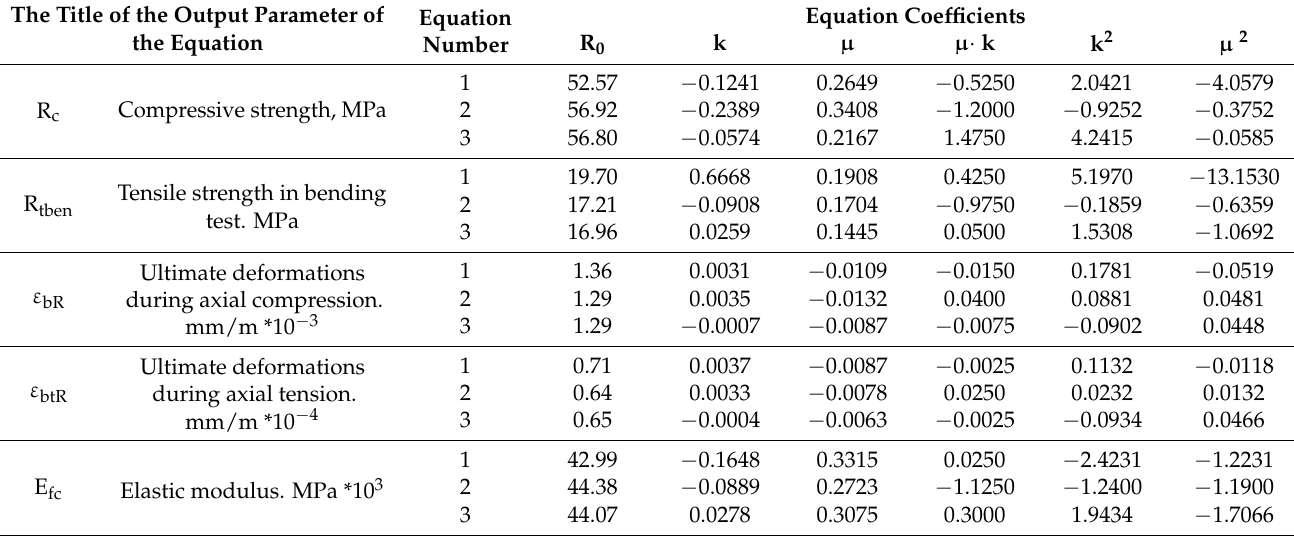
Table 9. Calculated coefficients of regression equations for prototypes of fiber-reinforced